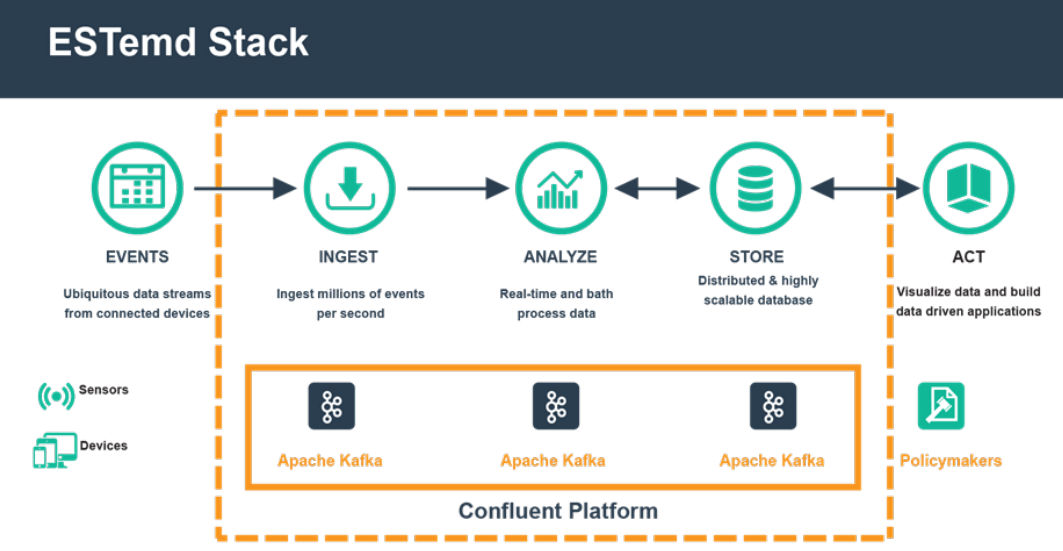
Figure 5. ESTemd Unified Middleware Framework Stack.